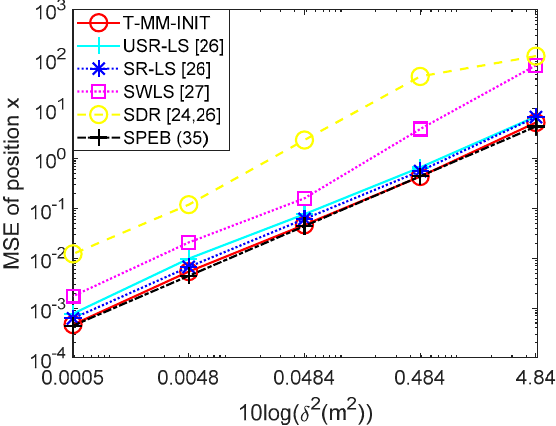
Figure 5. Conventional localization algorithm’s MSE comparison to the squared position error bound (SPEB) versus 𝛿 . Table 1. Mean square error of all localization algorithms .